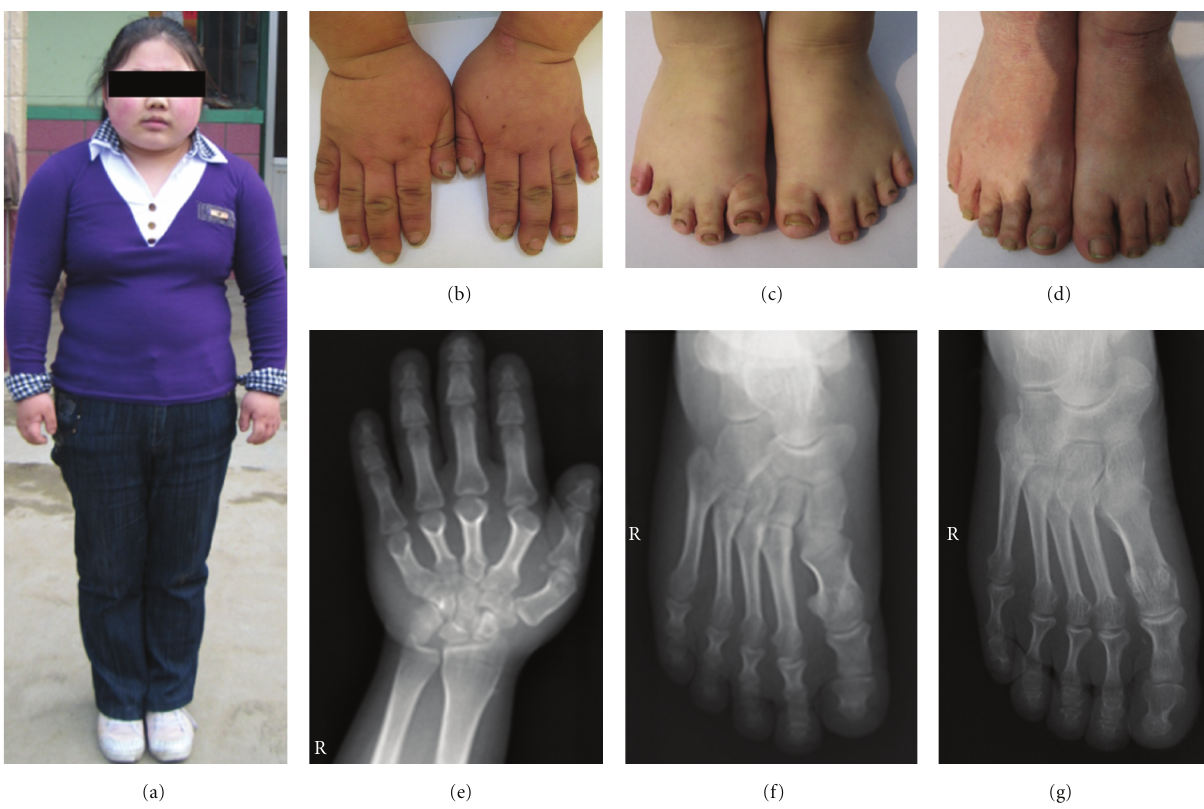
Figure 1: (a) The proband appeared short, obese, and face round. (b) The proband’s hands. (c) The proband’s feet. (d) Feet of the proband’s mother. (e) An X-ray of patient’s right hand showing that her metacarpals and phalanges are generally shortened. The both ends of the twice-fifth metacarpals are enlarged. The first distal phalanx, twice-fifth middle phalanges and twice-fifth distal phalanges are thickened. (f) The X-ray of the patient’s right foot showing that her metatarsus and phalanges are generally shortened, especially the first metatarsus and phalanx. The distal ends of the first metatarsus, first phalanx, and twice-fifth phalanges are enlarged. The proximal ends of the first phalanx and twice-fifth phalanges are widened. (g) The feet of the patient’s mother looked normal; however, an X-ray of her right foot showed that she had a similar, but less severe, phenotype to her daughter. Table 1: Blood biochemical and hormonal